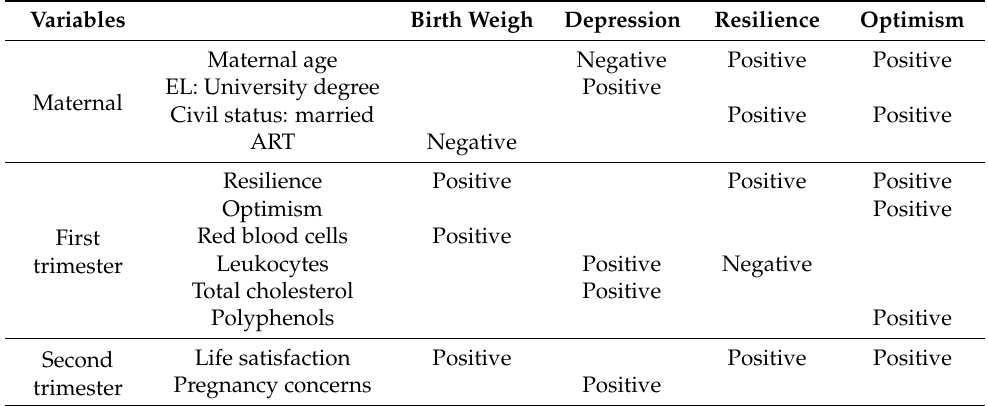
Table 4. Associations between maternal, first and second trimester variables with primary outcomes at the end of